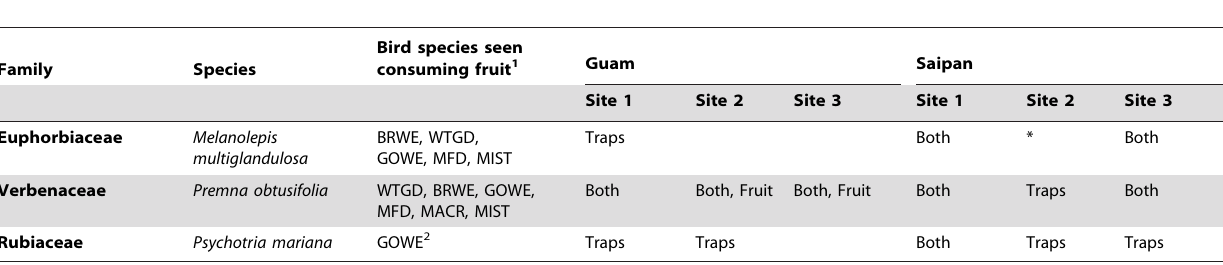
Table 1. Presence and dispersers of bird-dispersed tree species and their seeds on Guam and